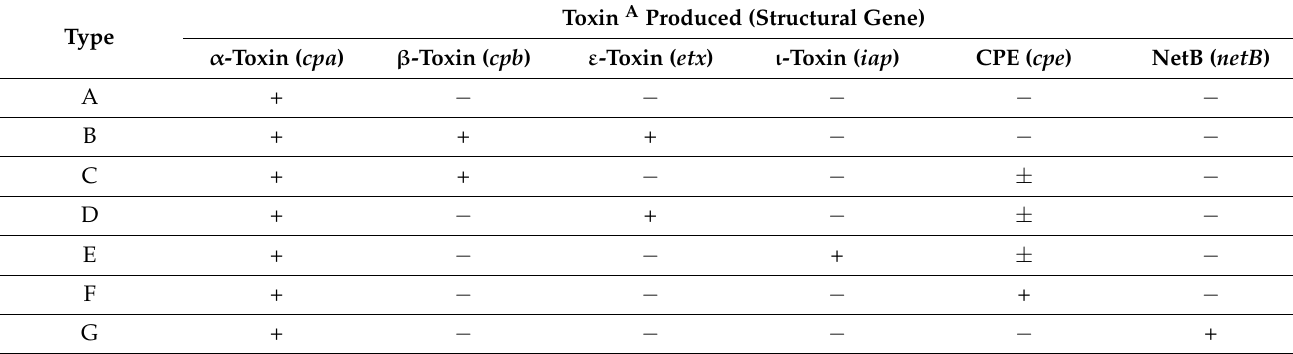
Table 1. Revised toxin-based classification of Clostridium perfringens